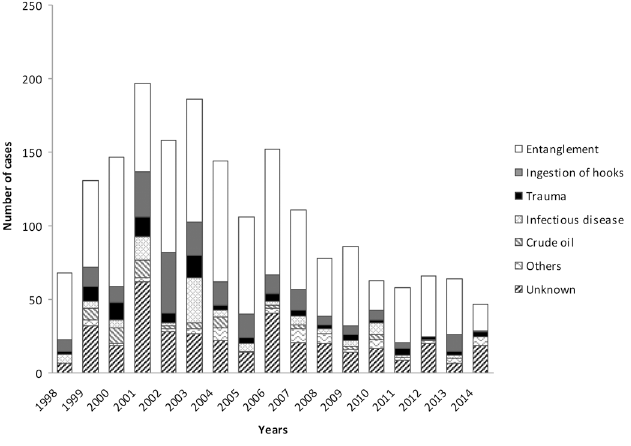
Fig 2. Annual variation in causes of admission of loggerhead turtles among the period 1998 –